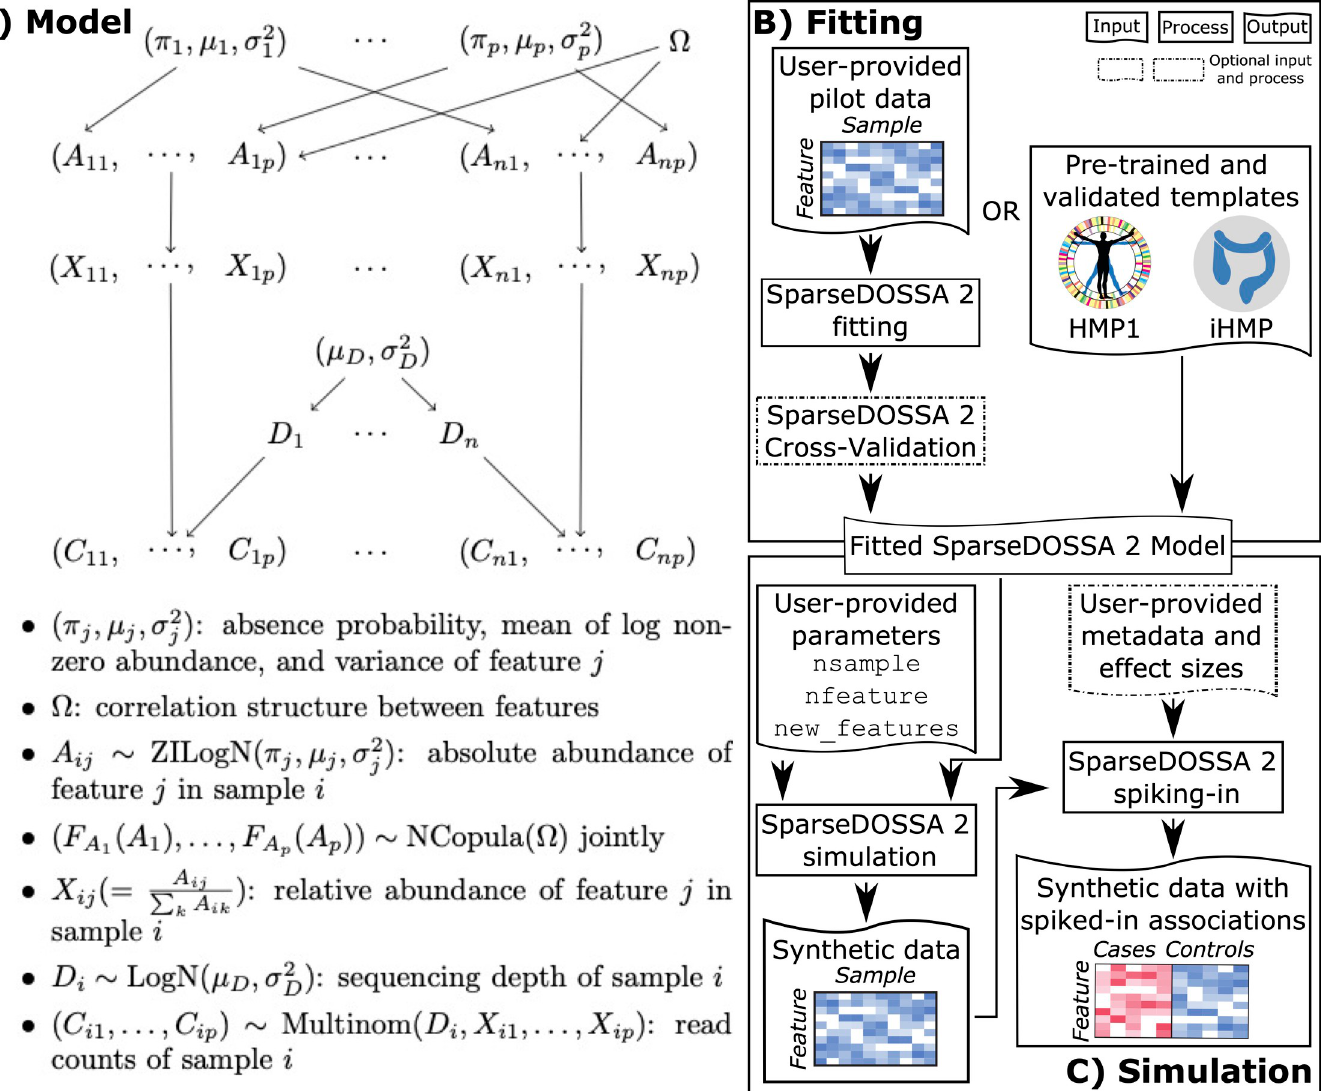
Fig 1. A hierarchical model for microbial community feature profiles. A) SparseDOSSA comprises a hierarchical model to capture the generation mechanism of microbial sequencing counts, including components for “hidden” absolute abundances, sequencing depth (and thus compositional relative abundances), zero inflation, and feature-feature and feature-environment interactions. Notations not defined in the figure: F ð�Þ : cumulative density function (CDF) for the absolute abundance of A j : mean and variance of the log normal sequencing depth distribution. B) SparseDOSSA can be fitted to varied microbial community types using cross- feature A j . μ D , s 2 D validation procedures by users; the software also provides pre-trained models are provided for human microbiome template datasets. This allows for C) simulation of either null or "true positive" association spiked-in synthetic datasets, to facilitate microbiome benchmarking or power analysis studies.